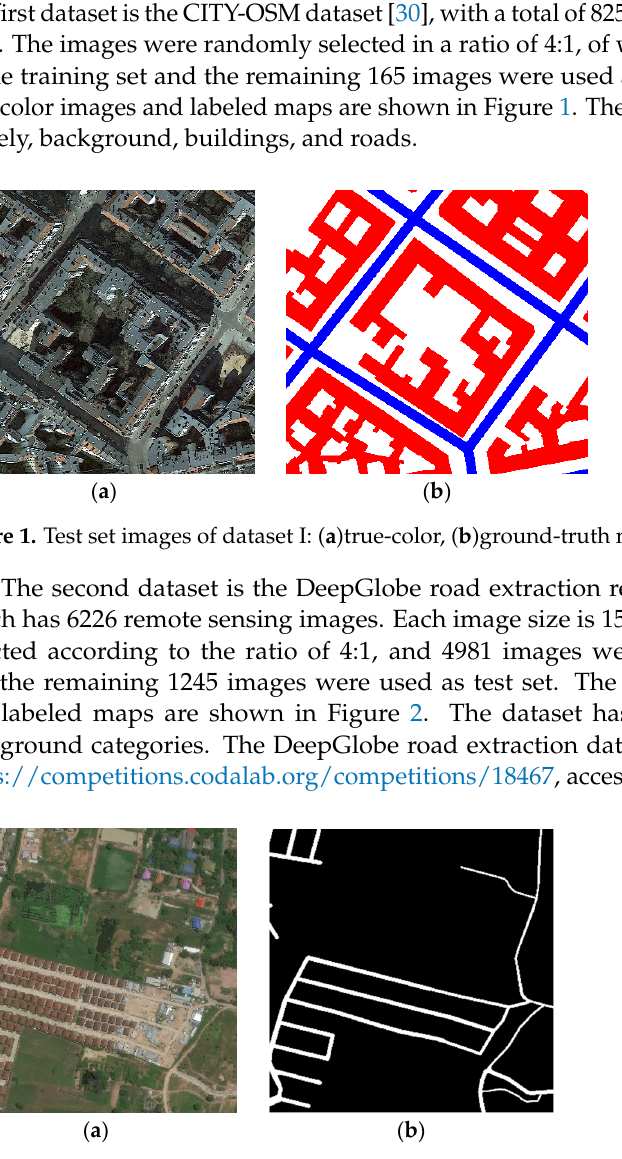
Figure 2. Test set images of dataset II: ( a ) true-color, ( b ) ground-truth maps. The third dataset is the CHN6-CUG dataset [31]. CHN6-CUG contains 4511 labeled images of 512 × 512 size, divided into 3608 instances for the training set and 903 for the test set. The test set’s true-color images and labeled maps are shown in Figure 3. The CHN6-CUG road dataset is a new large-scale satellite image dataset of representative cit- ferent levels of urbanization, city size, development degree, urban structure, and history